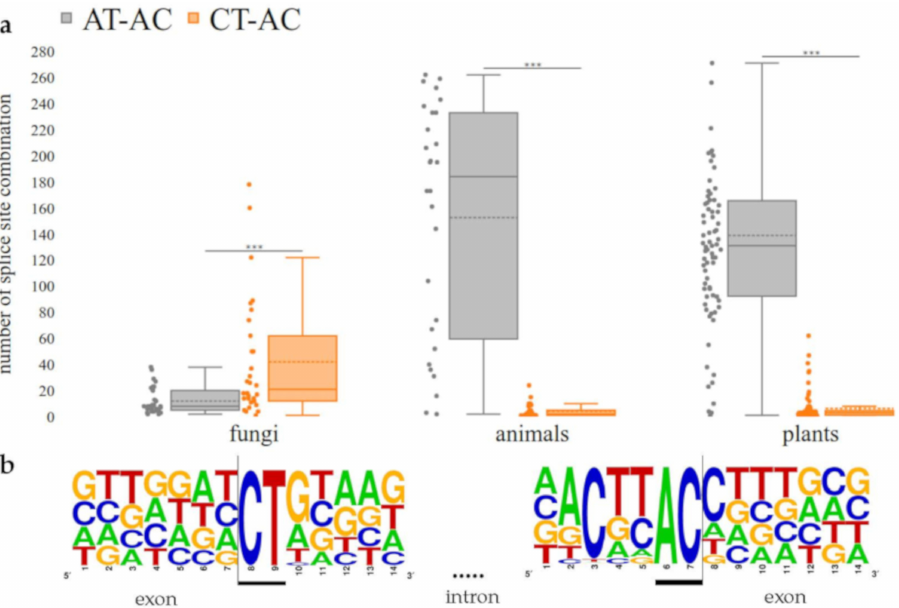
Figure 3. CT-AC frequency exceeds AT-AC frequency in the annotation of fungal genome sequences. ( a ) Number of the minor non-canonical CT-AC splice site combination in comparison to the major non-canonical splice site combination AT-AC in each kingdom (Mann-Whitney U-Test; fungi: p ≈ 0.00035, animals: p ≈ 9.560 × 10 − 10 , plants: p ≈ 5.464 × 10 − 24 ). The dashed line represents the mean frequency of the respective splice site combination over all investigated species. ( b ) Sequence logo for the splice site combination CT-AC in four selected fungal species ( Alternaria alternata, Aspergillus brasiliensis, Fomitopsis pinicola and Zymoseptoria tritici ). In total, 67 supported splice sites with this combination were used to generate the sequence